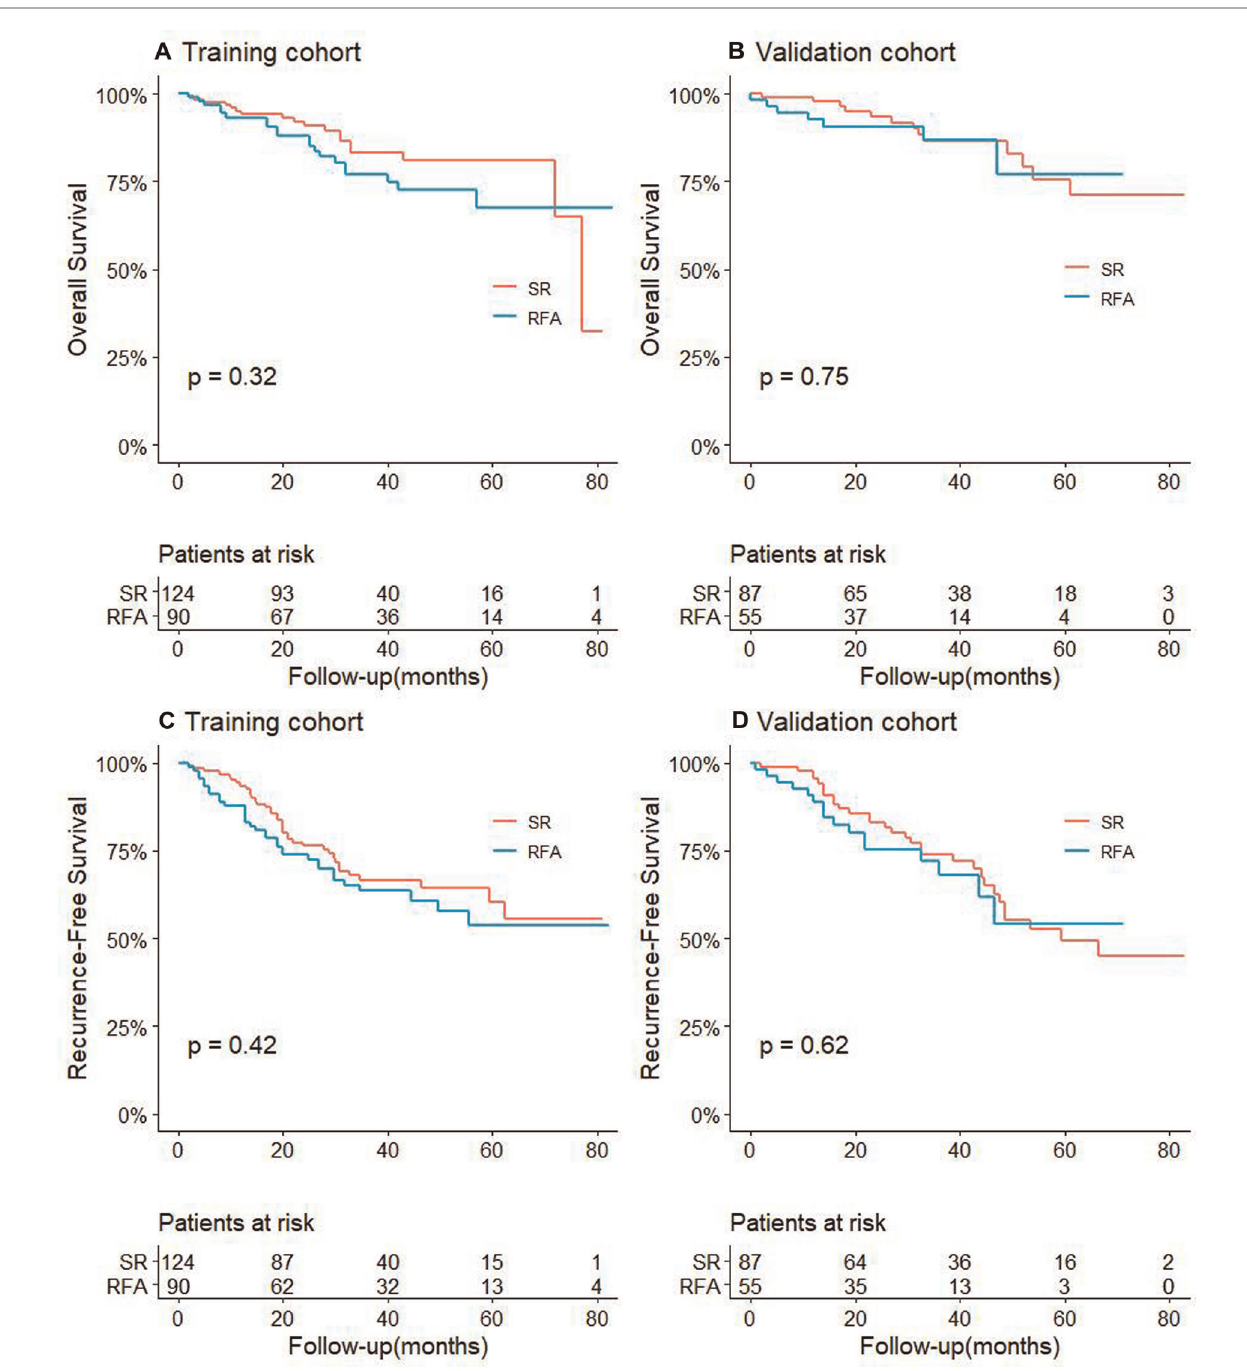
FIGURE 1 | Comparison of OS between RFA and SR groups in training cohort ( A ) and validation cohort ( B ) for patients with CTC-negative; RFS comparison between RFA and SR groups in training cohort ( C ) and validation cohort ( D ) for patients with